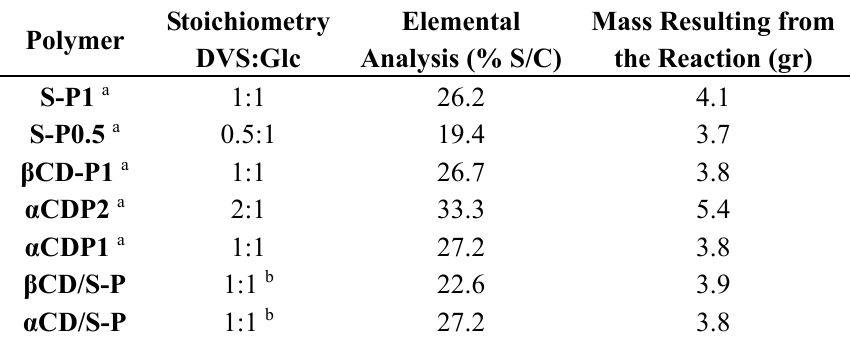
Table 1. Features of DVS cross-linked homo- ( S-Pn and CD-Pn ) and hetero-polymers ( CDS/S-P ). Polymer